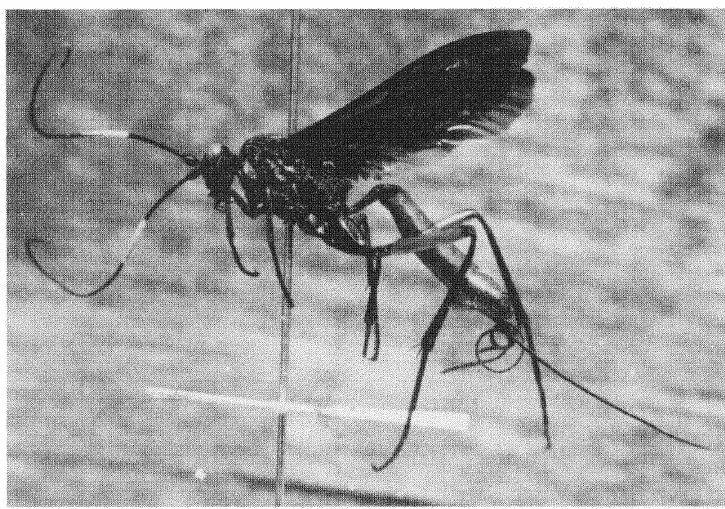
Fig. 2. Cosmiocryptus huascar,